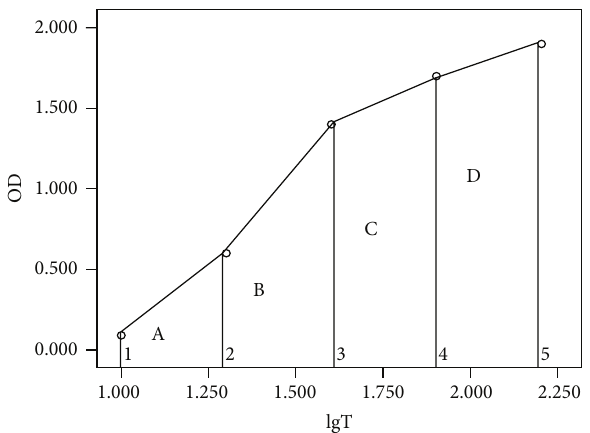
Figure1:Schematicdiagramoftotalantioxidantcapacity,calculated as the total area under the plotted